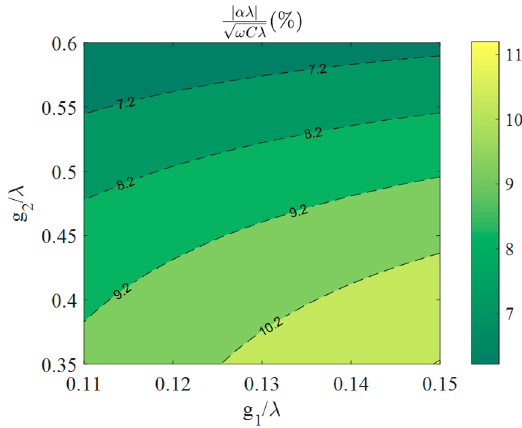
Figure A4. Contour of the transduction coefficient as a function of g 1 and g 2 . We processed the unidirectional angle θ with θ = θ − 360 so that it is in the range of − 180 ° to 180 ° , shown in Figure A5.